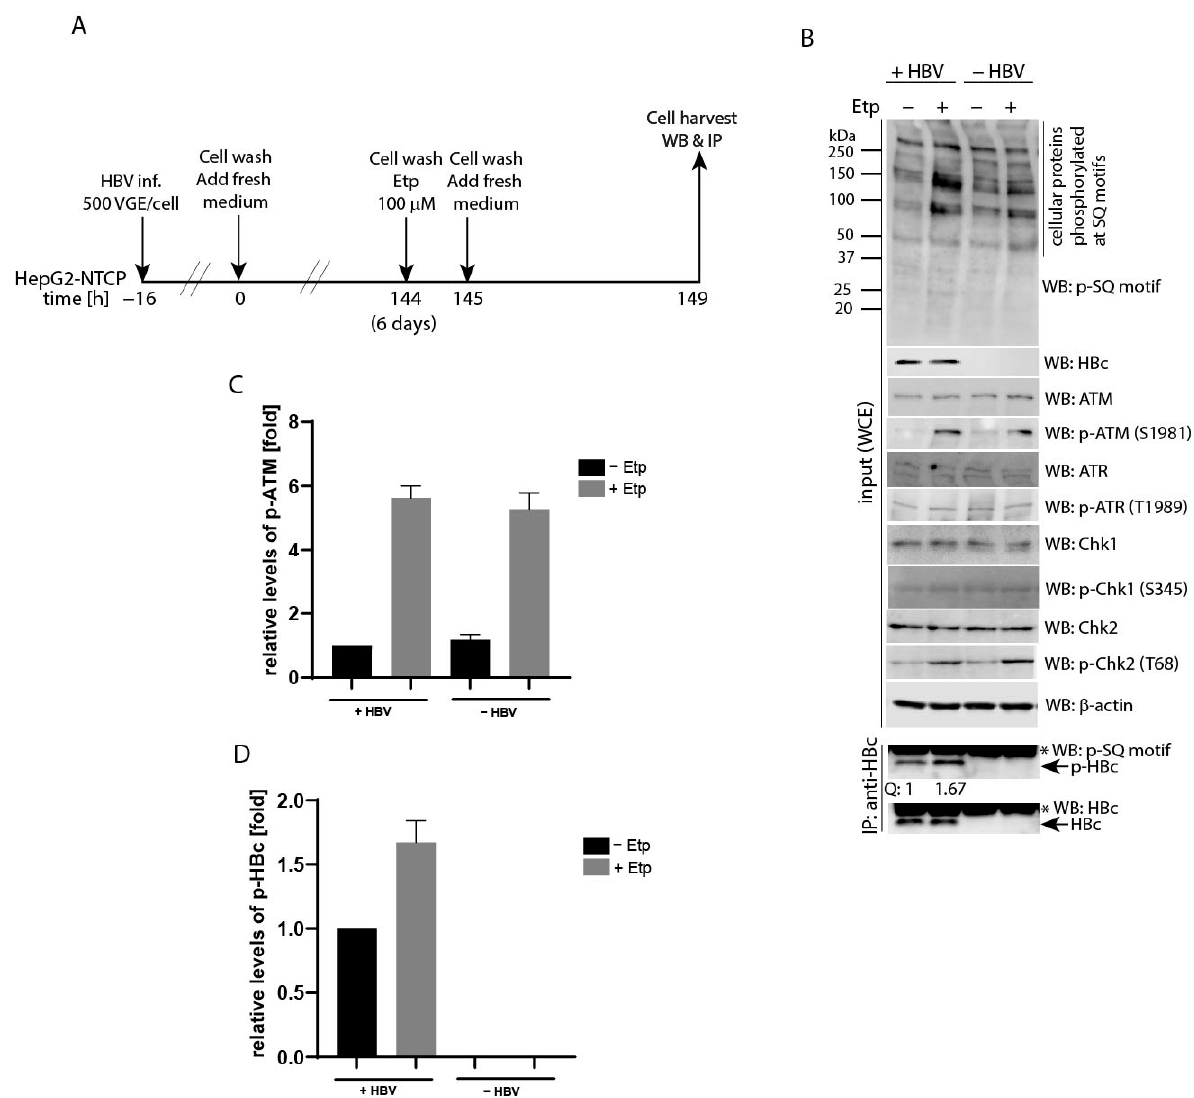
Figure 7. Etoposide treatment upregulates phosphorylation of the HBc protein in HBV-infected cells. ( A ) Experimental outline: HepG2-NTCP cells were infected with HBV (MOI 500 VGE per cell) or left uninfected. Six days post-infection, the cells were treated with 100 μ M etoposide (+) for 1 h, or left untreated (0.1% DMSO, marked as − ). After treatment, the cells were washed twice and cultured for an additional 4 h. ( B ) The isolated protein lysates (30 μ g) were analyzed by Western blot (input) with antibodies (from the top to the bottom) against a phospho-SQ motif (p-SQ), HBc, ATM, p-ATM, ATR, p-ATR, Chk1, p-Chk1, Chk2, p-Chk2 and β -actin (loading control). IP:anti-HBc represents the cell lysates (1 mg) that were immunoprecipitated with anti-HBc, and the precipitated complexes were analyzed by Western blot with an anti-phospho-SQ motif (p-SQ) or anti-HBc (two bottom panels). The intensity of the HBc phosphorylation signal was quantified (line Q:) and normalized to the level of precipitated HBc. The level of HBc phosphorylation in non-treated cells was set to 1. The p-HBc values were calculated as mean of two independent experiments. The asterisks indicate a non-specific IgG signal. ( C , D ) The densitometric analyses of the ATM phosphorylation signal (p-ATM; shown in ( C )) and the HBc phosphorylation signal (shown in ( D )) that were determined in ( B ) using Image Studio Lite Software. The data are shown as mean ± SD from two independent experiments.